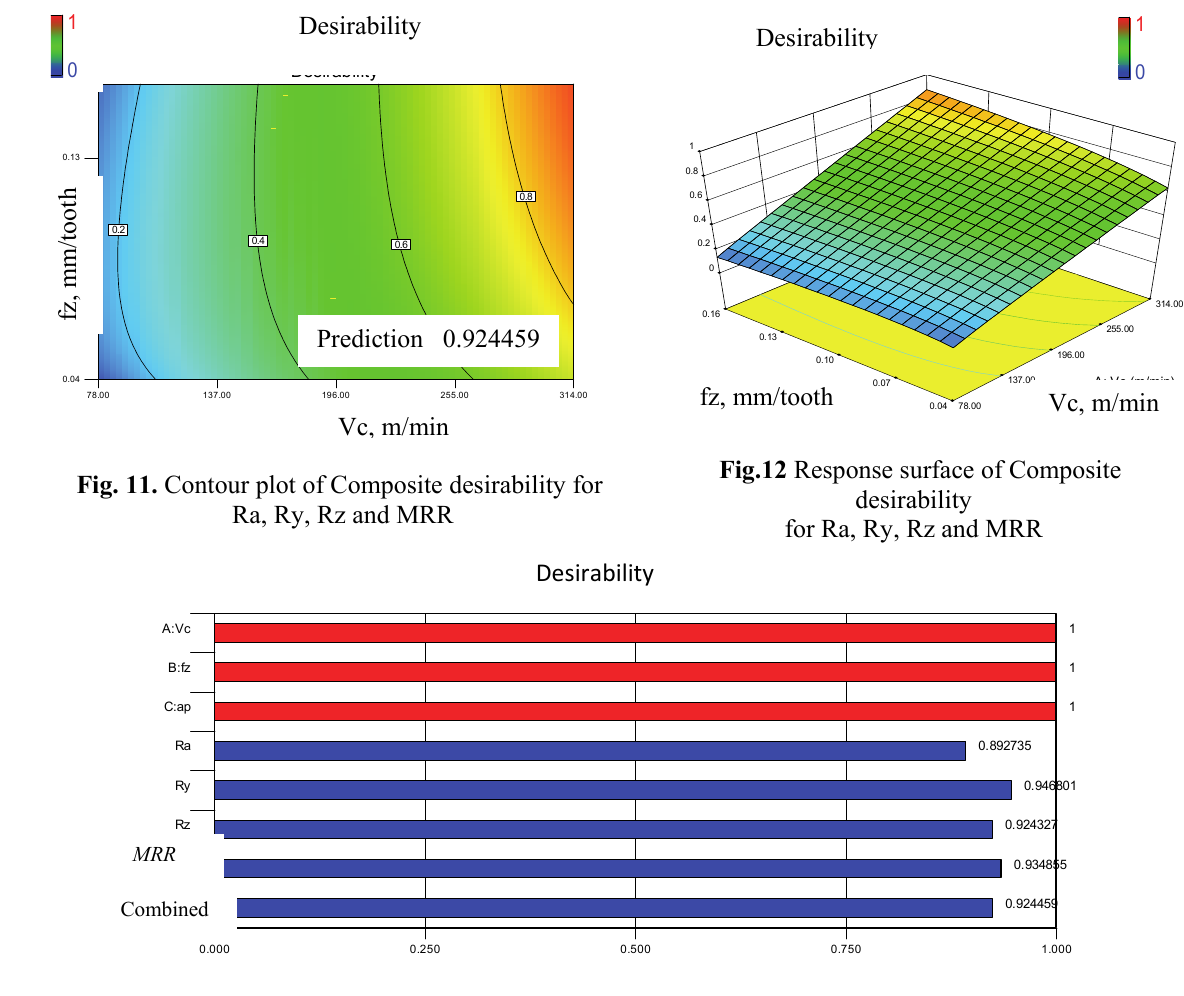
Fig. 13. 3D bar graph of desirability for Ra, Ry, Rz and